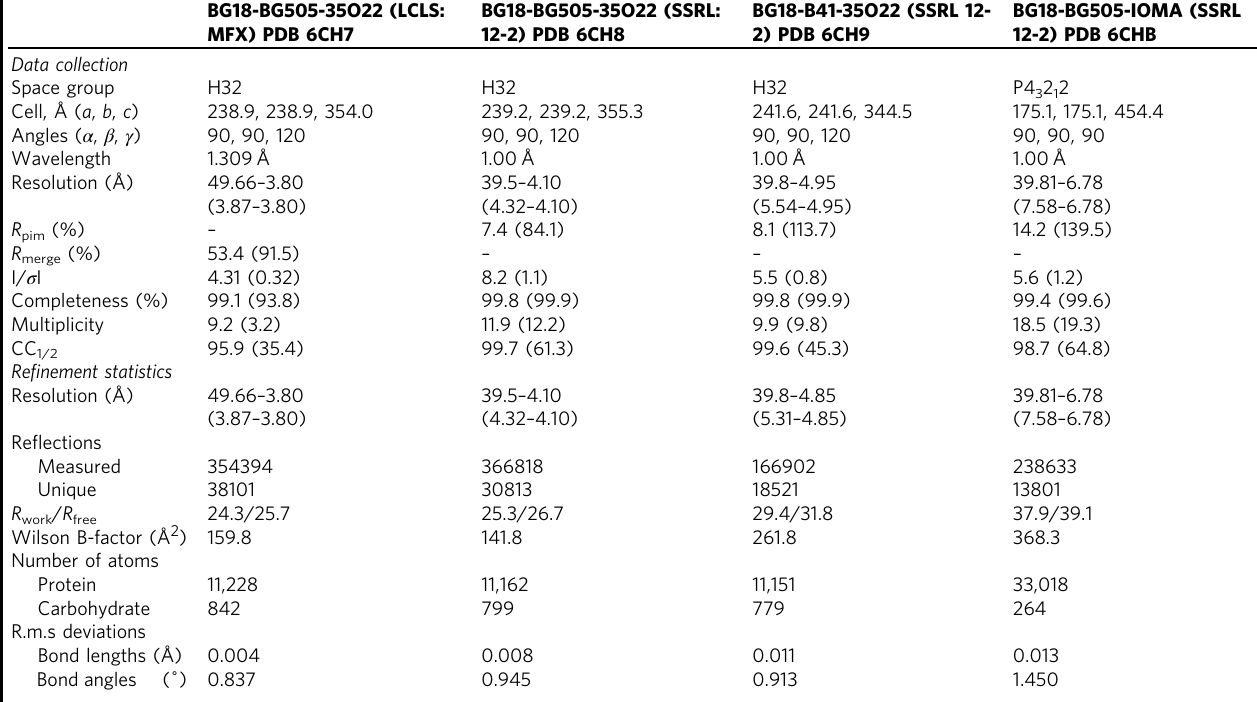
Table 1 Data collection and re fi nement statistics